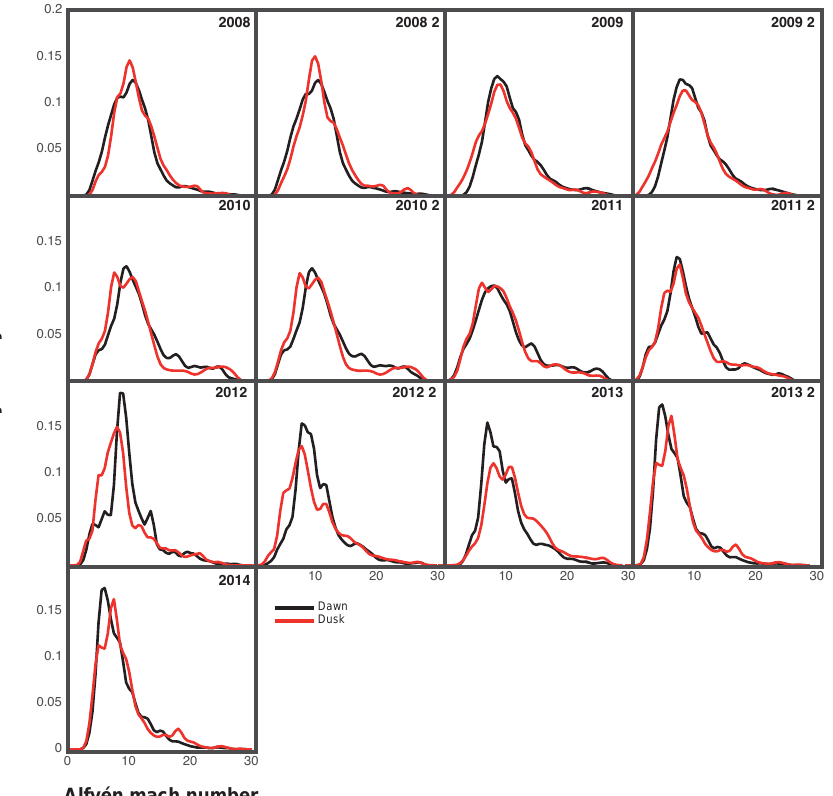
Figure B1. Yearly probability density functions of solar wind Alfvén Mach number which correspond to magnetosheath data points on the dawn and dusk flanks. The “2” in each yearly label indicates that the data set spans the middle of that year to the middle of the next. e.g. 2012 2 = July 2012–July